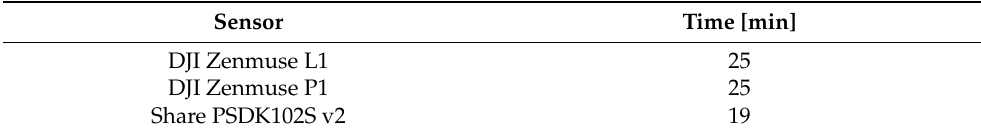
Table 1. Approximate time of execution of the